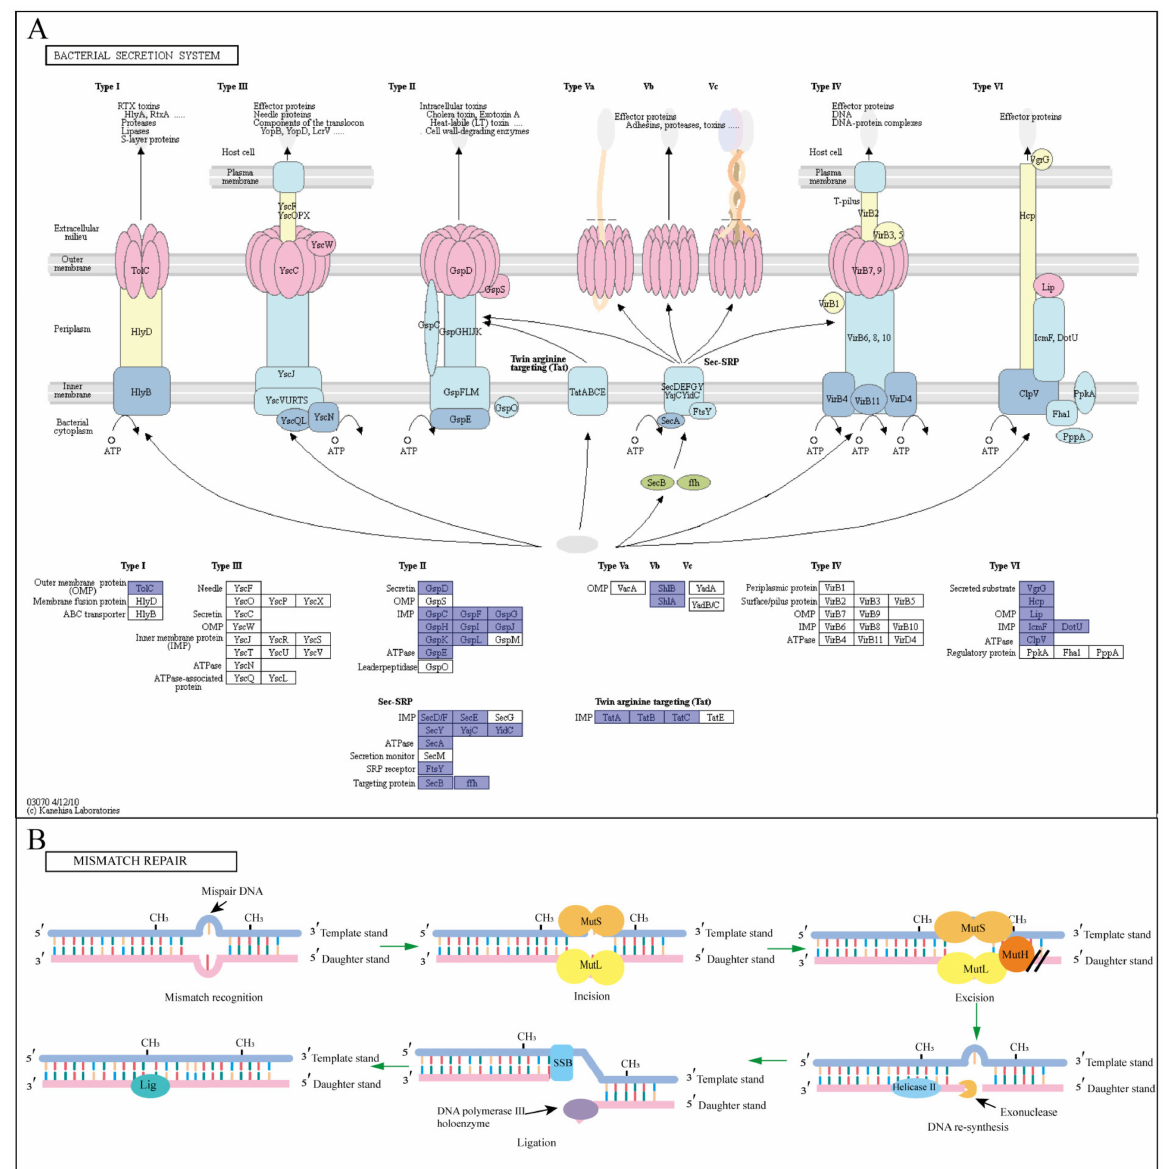
Figure 4. Graphic illustration of the defense mechanism of the strain P1 ( A ) bacterial secretory system [65]. The two-step secretory pathway includes Sec and Tat pathways, and secretions can pass through the plasma membrane. The Type II pathway is mainly used to secrete various hydrolases and toxins, and the one-step secretion pathway includes a Type VI pathway, which is mainly responsible for transporting secreted substances to the outer membrane of bacteria; ( B ) mismatch repair system, the proteins involved in the figure are annotated in the genome of strain